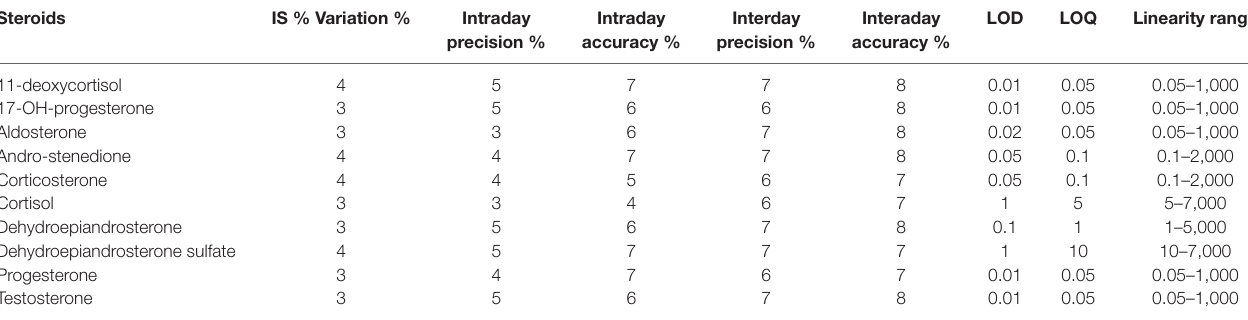
TaBle 3 | Precision and accuracy error %, limit of detection (LOD), limit of quantitation (LOQ), and linearity range for each steroid. steroids is % Variation % intraday